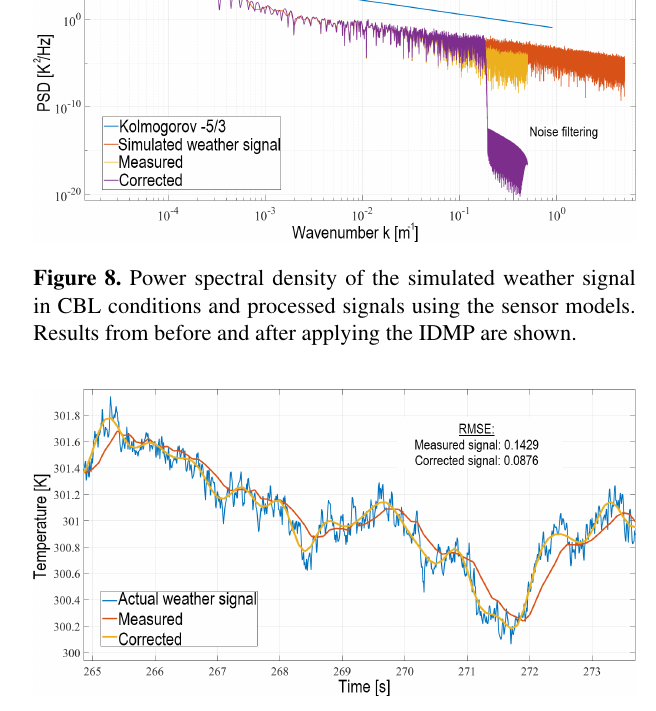
Figure 9. Time series of the simulated weather signal in CBL con- ditions and processed signals using the sensor models. Results from before and after applying the IDMP are